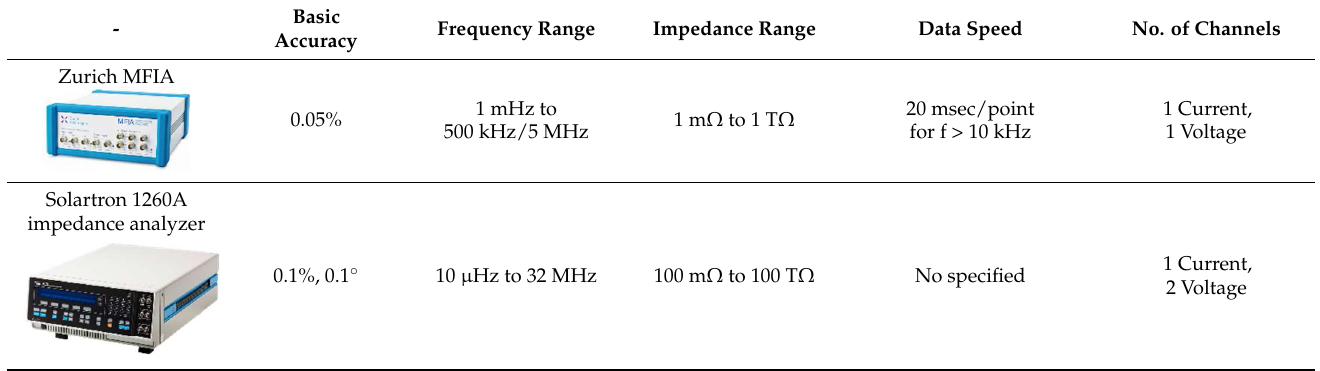
Figure 12. Terminal arrangement of commercial impedance analyzers for: ( a ) impedance measure- ment of DUT; ( b ) mutual inductance measurement between the excitation and detection coils. Table 5. Comparison of two commercial impedance analyzers.